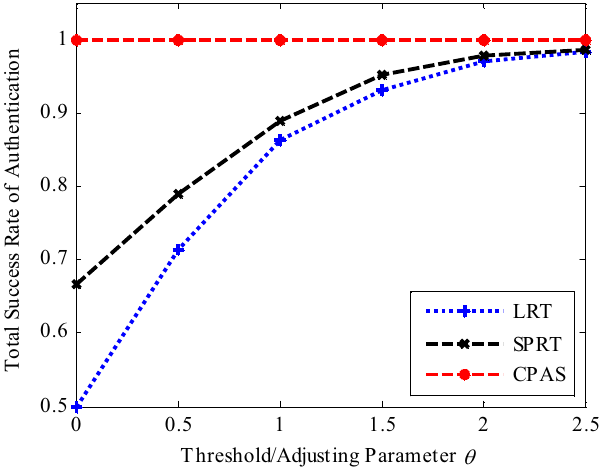
Figure 14. Total authentication success rate of different authentication